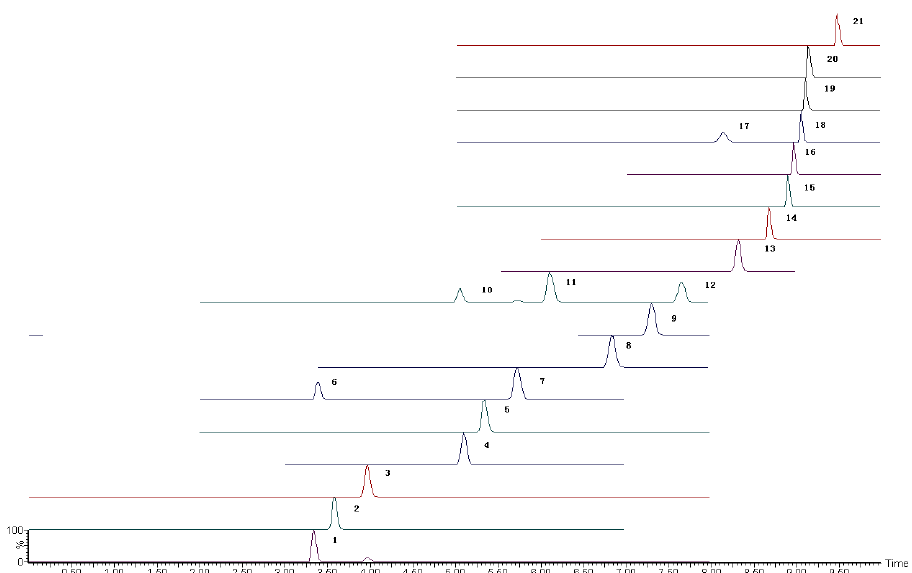
Figure 1. The extracted ion chromatograms of 21 SAs. 1. Sulfisomidine; 2. sulfametoxydiazine; 3. sulfadiazine; 4. sulfathiazole; 5. sulfachloropyridazine; 6. sulfamerazine; 7. sulfafurazole; 8. sulfamethizole; 9. sulfamethoxazole; 10. sulfamethazine; 11. sulfamethoxypyridazine; 12. sulfamonomethoxine; 13. sulfachloropyrazine; 14. sulfadoxine; 15. sulfisoxazole; 16. sulfabenzamidec; 17. sulfaphenazole; 18. sulfadimethoxine; 19. sulfapyrazole; 20. sulfaquinoxaline; 21. sulfanitran.